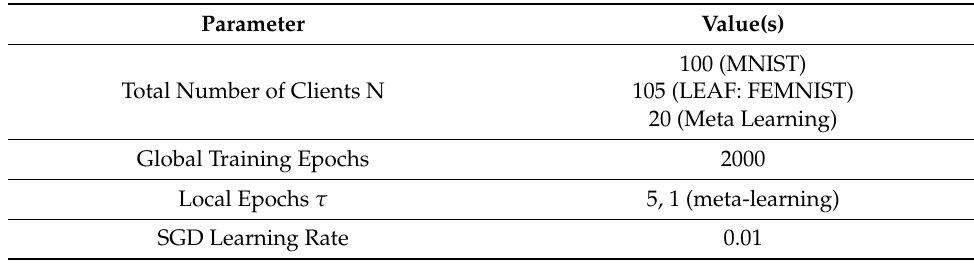
Table 1. Experimental